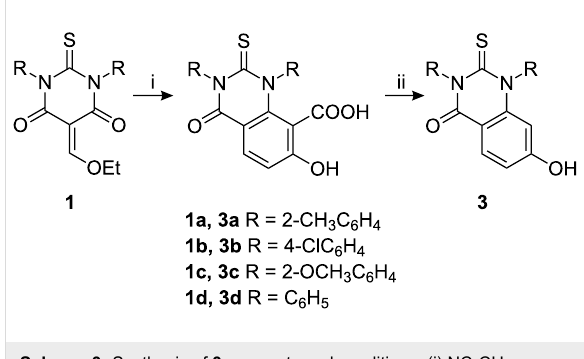
Scheme 3: Synthesis of 3 , reagents and conditions: (i) NC-CH 2 - CO